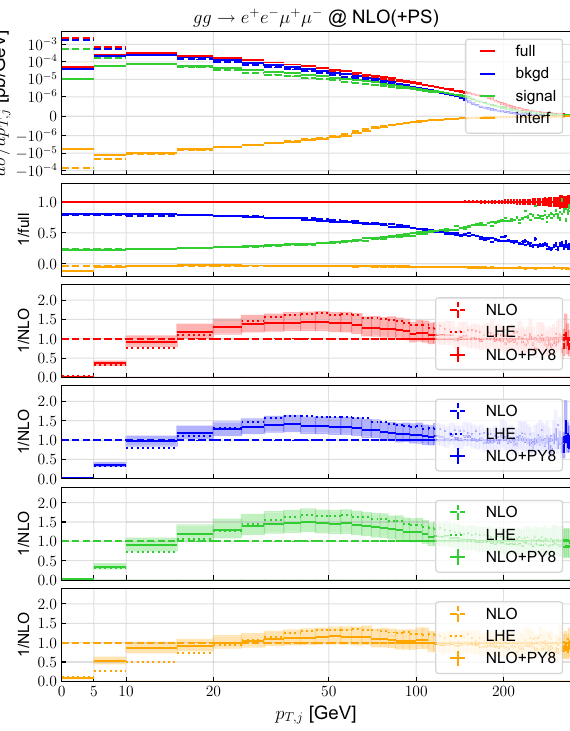
Fig. 7 Differential distribution in transverse mass m T of the four- lepton system in gg → e + ν e μ − ¯ ν μ at NLO matched to PYTHIA 8 . Predictions, colour coding and bands as in Fig. 3